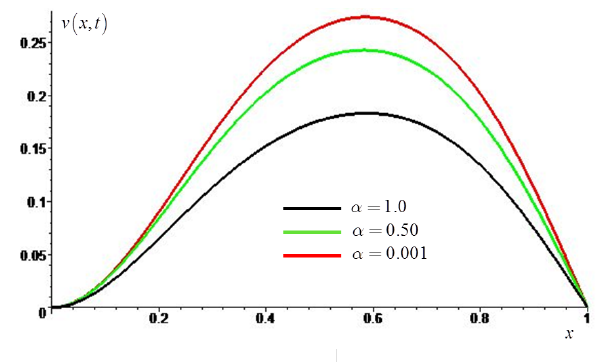
Fig. 3. The deflection due to the nonhomogeneous solution for various nonhomogeneity parameters ˛ .